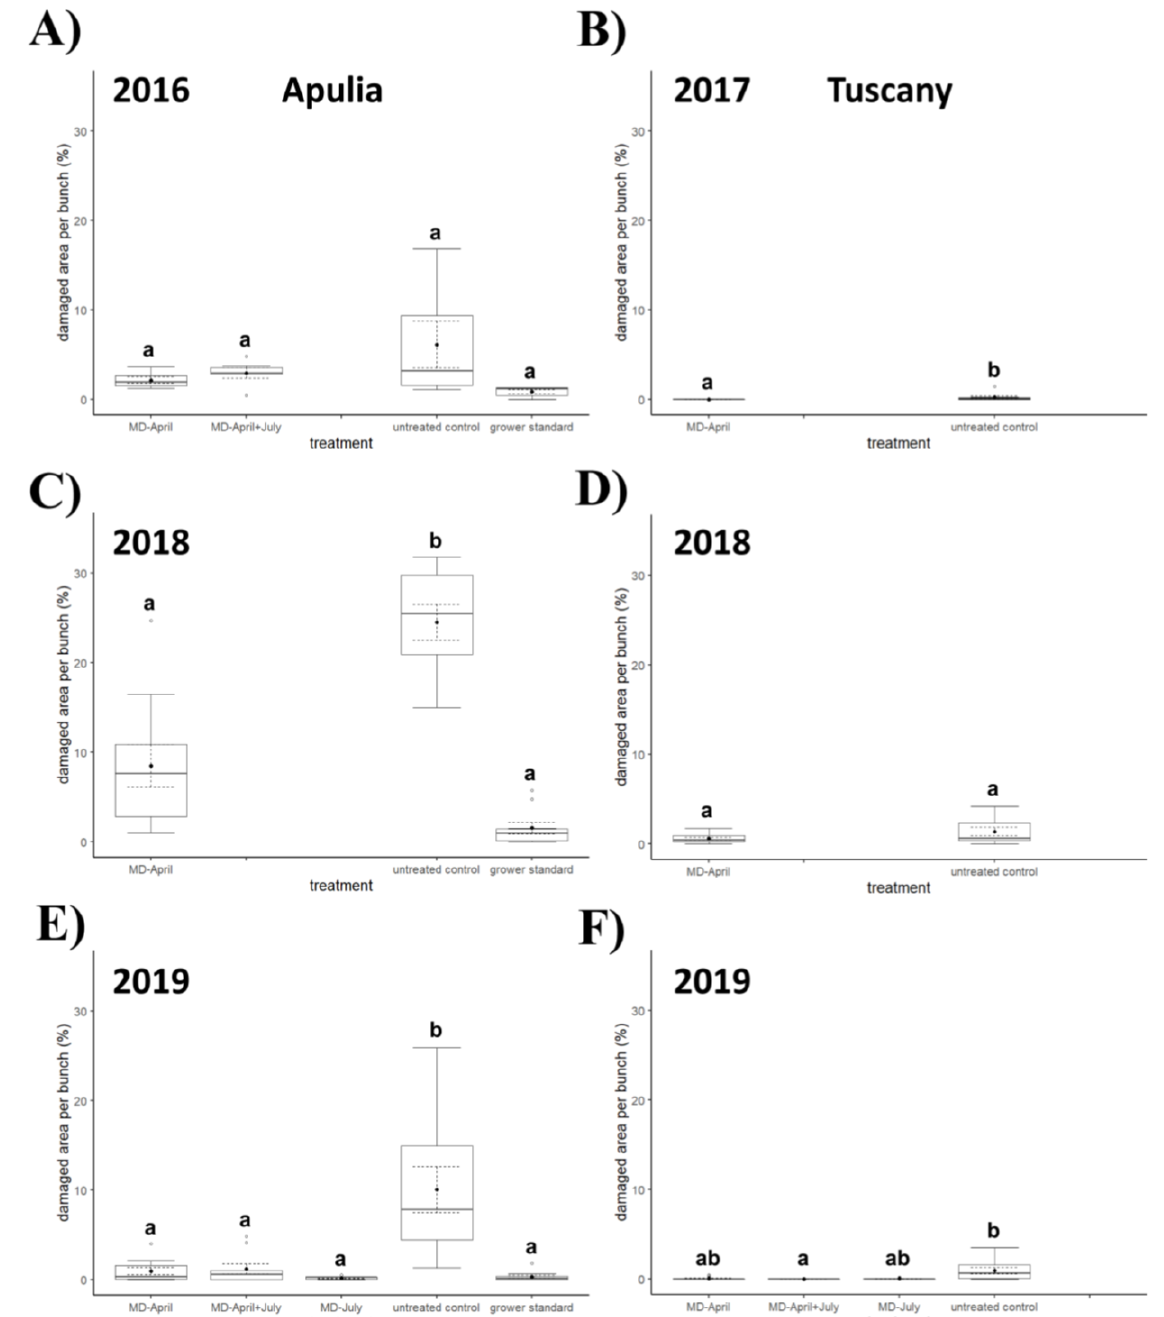
Figure 4. Impact of mating disruption (MD) using Isonet CGX111 dispensers on Cryptoblabes gnidiella damaged area (%) per bunch among treatments and untreated control plots in Apulia ( A , C , E ) and Tuscany ( B , D , F ) during three-year samplings. Boxplots indicate the median (solid line) and the range of dispersion (lower and upper quartiles and outliers) of the parameter; black dot and dashed line indicate mean value and standard error, respectively. Different letters above boxplots indicate significant differences among treatments (Wilcoxon test for comparisons between two plots or Kruskal–Wallis test for multiple comparisons, the latter followed by Nemenyi post hoc test; p < 0.05).